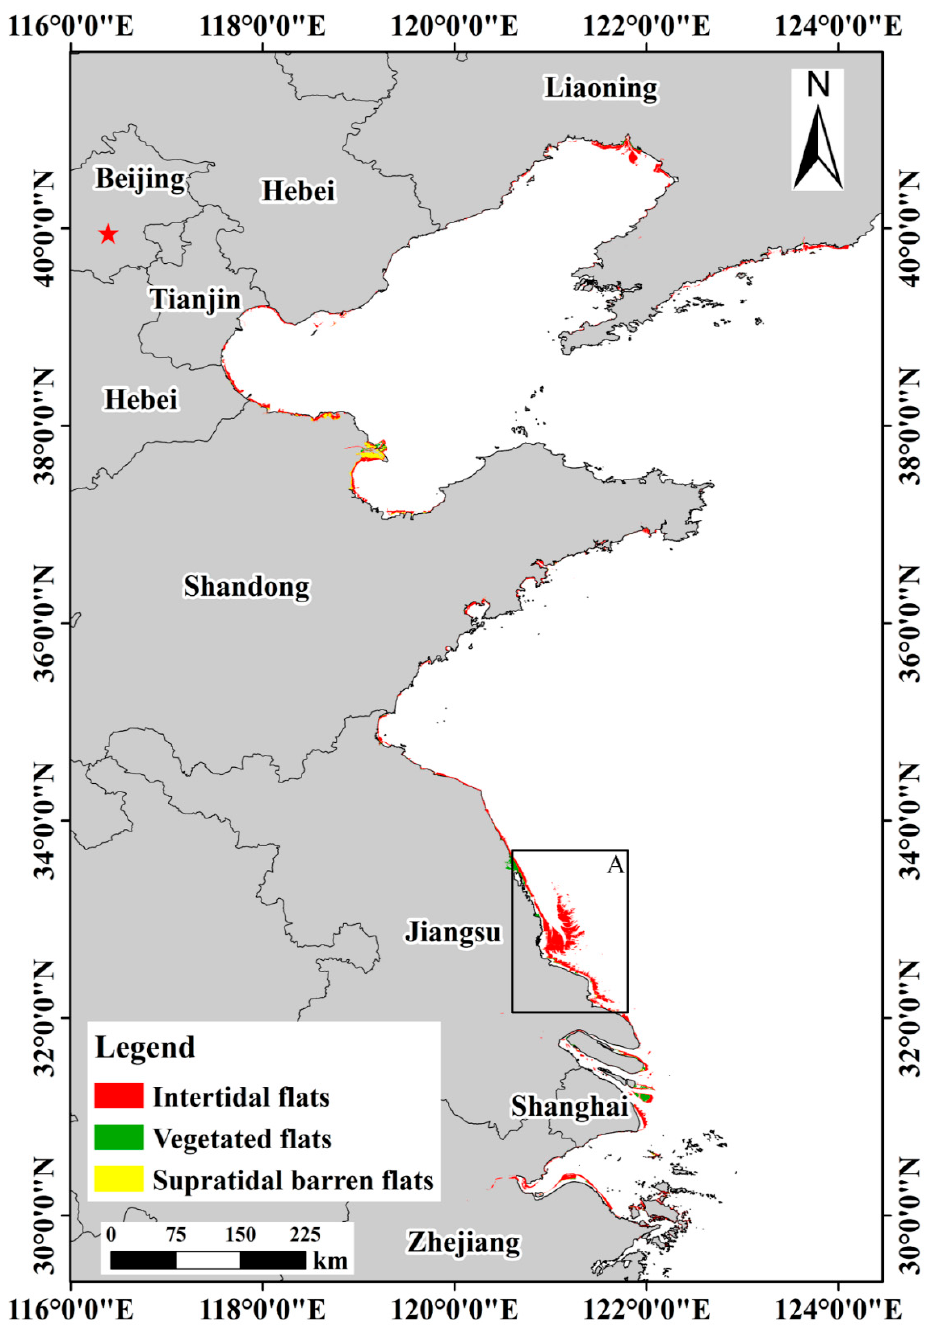
Figure 8. Tidal flat map generated by proposed approach in this study.